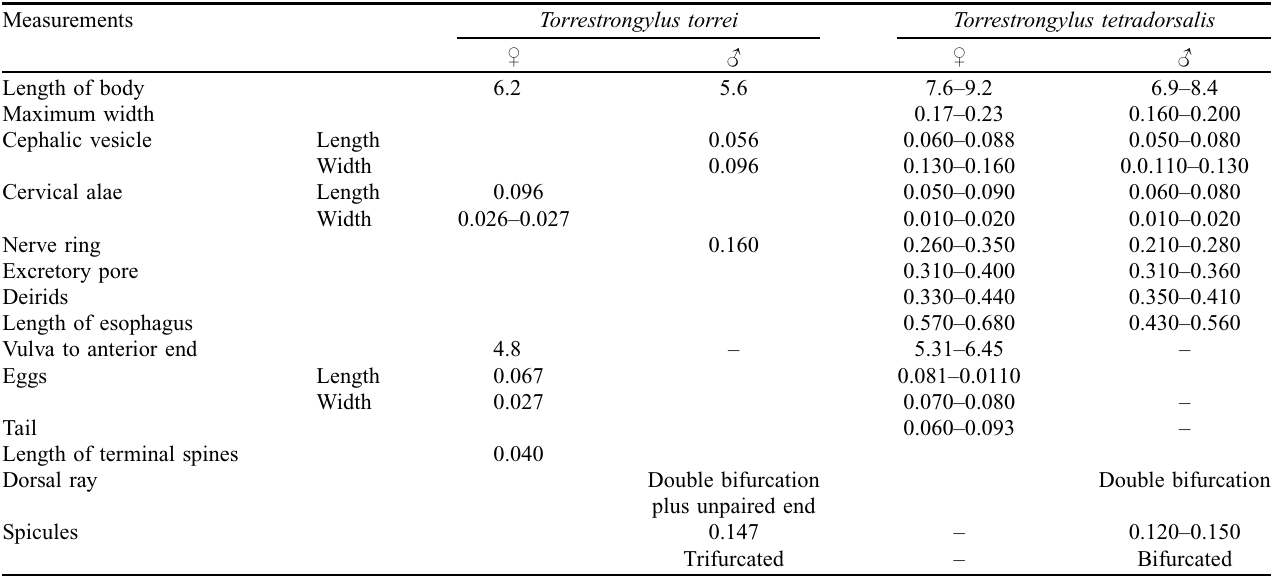
17: Deirid. 18: Lateral view of caudal bursa, showing projections supported by bursal rays. 19: Ventral view of tail of female, featuring anus and terminal spines. 20: Subterminal view of tail of female, showing all three cuticular projections and terminal filament. Table 1. Comparative measurements of key diagnostic traits of Torrestrongylus torrei and T . tetradorsalis . All measurements are in